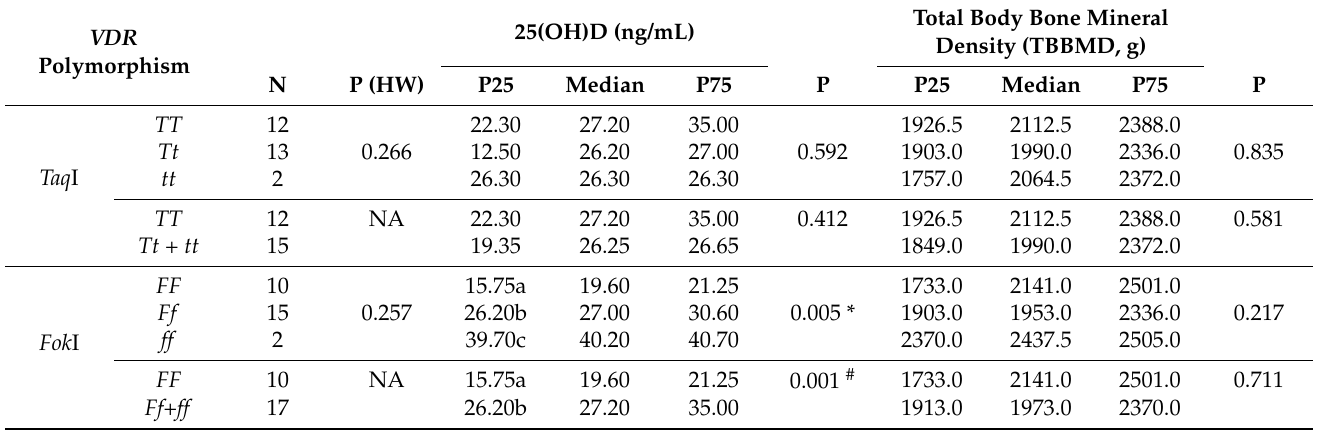
Table 3. VDR Taq I and VDR Fok I polymorphisms’ genotypic distribution, according to the